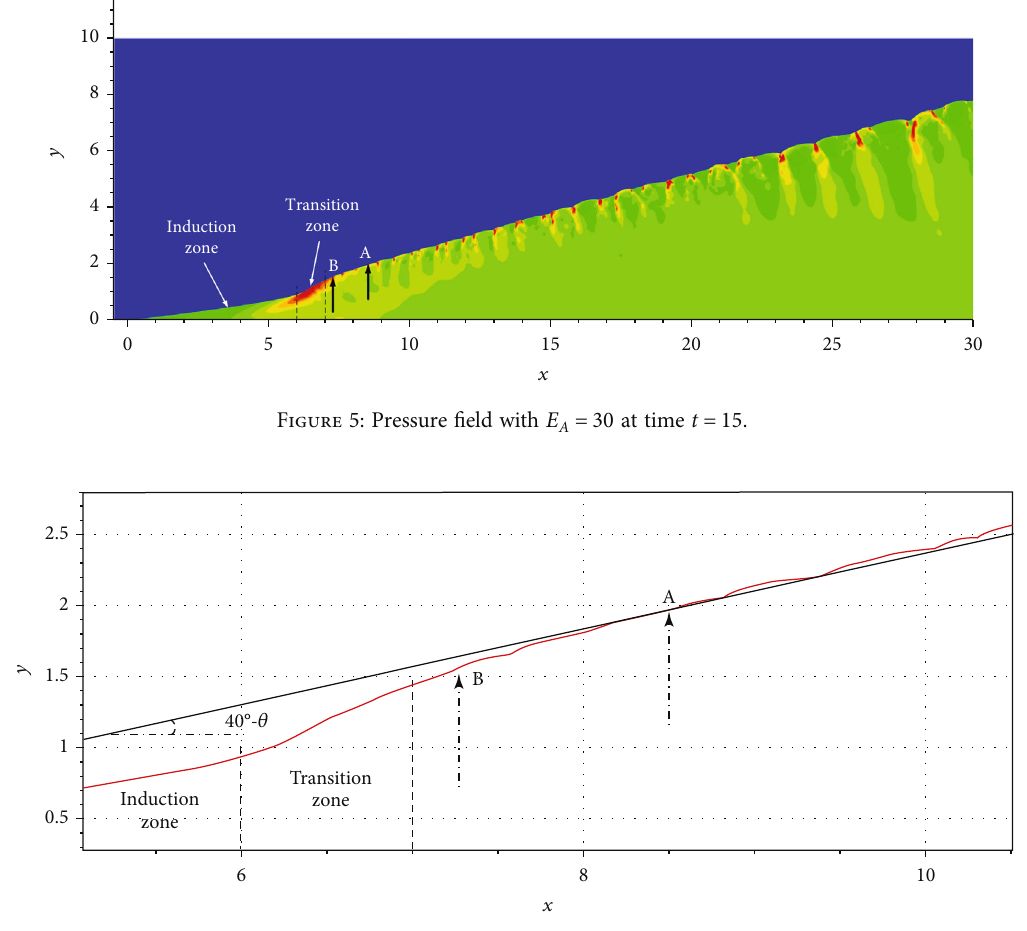
Figure 6: Leading shock trajectory with E